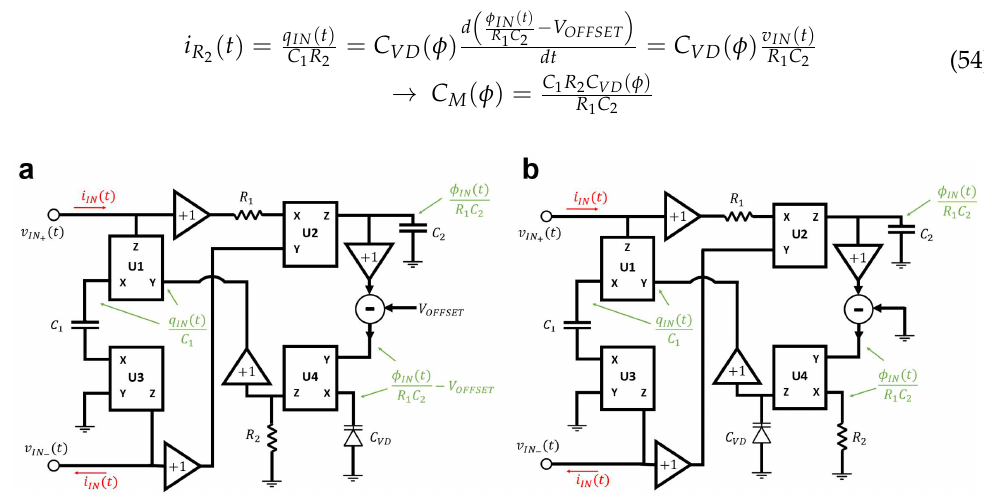
Figure 18. ( a ) Universal circuit for the emulation of grounded mem-elements proposed by Yu et al. [61]. ( b ) Mutator for the emulation of memcapacitors, ( c ) mutator for the emulation of meminductors.